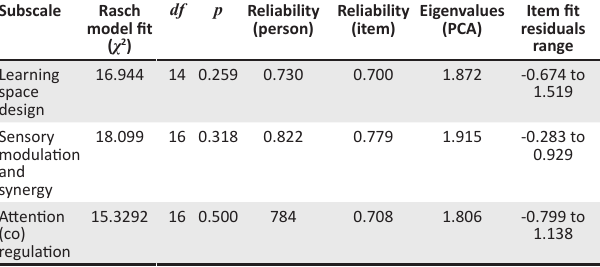
TABLE 4: Rasch analysis findings for three Sensory Classroom Teacher Questionnaire constructs.